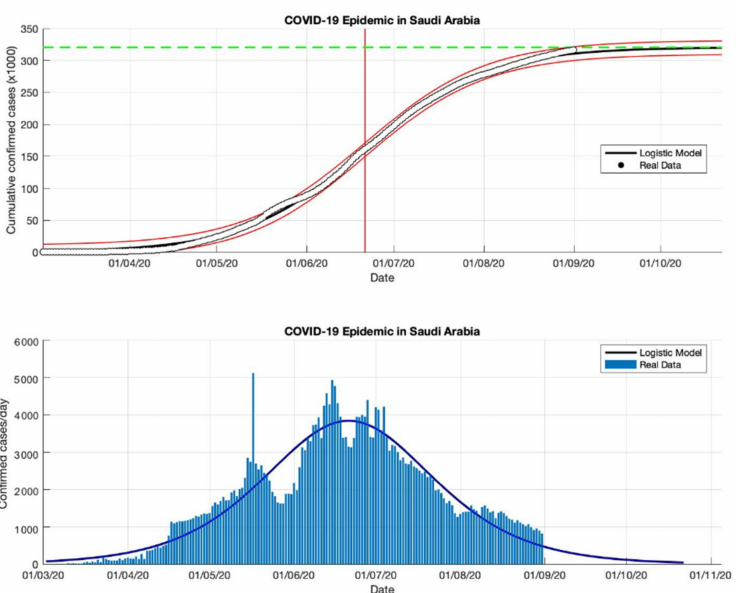
Figure 10. In the above figure, the prediction results of the logistic growth model for cumulative infected cases are compared with the actual data, while the two red lines between the black lines represent a prediction error limit of about 5%. The dashed green line predicts the total size of infected cases in the final phase of the epidemic. The red line intersects the cumulative case curve to predict the turning point or peak point of the epidemic (this line is parallel to the top of the curve from the below figure). In the below figure, the prediction results of this model for daily infected cases in